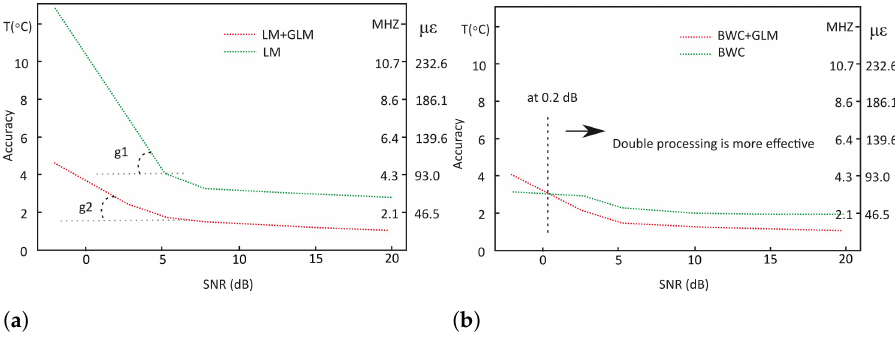
Figure 9. Prediction accuracy demonstrated by studied methods: ( a ) LM; ( b )